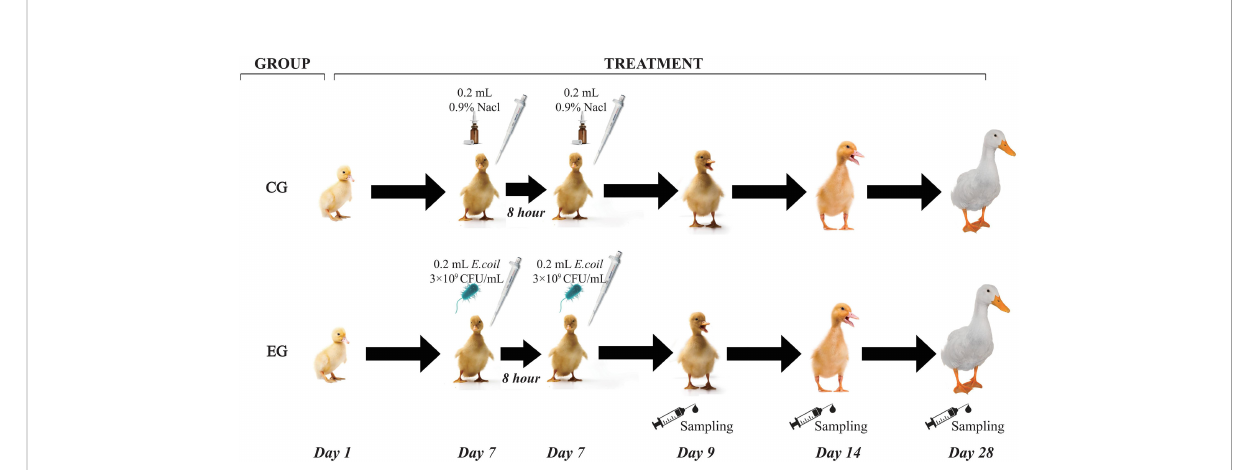
FIGURE 1 Work fl ow of the experiment. CG, control group (non-challenged with pathogenic Escherichia coli O88); EG, experiment group (challenged with pathogenic E. coli